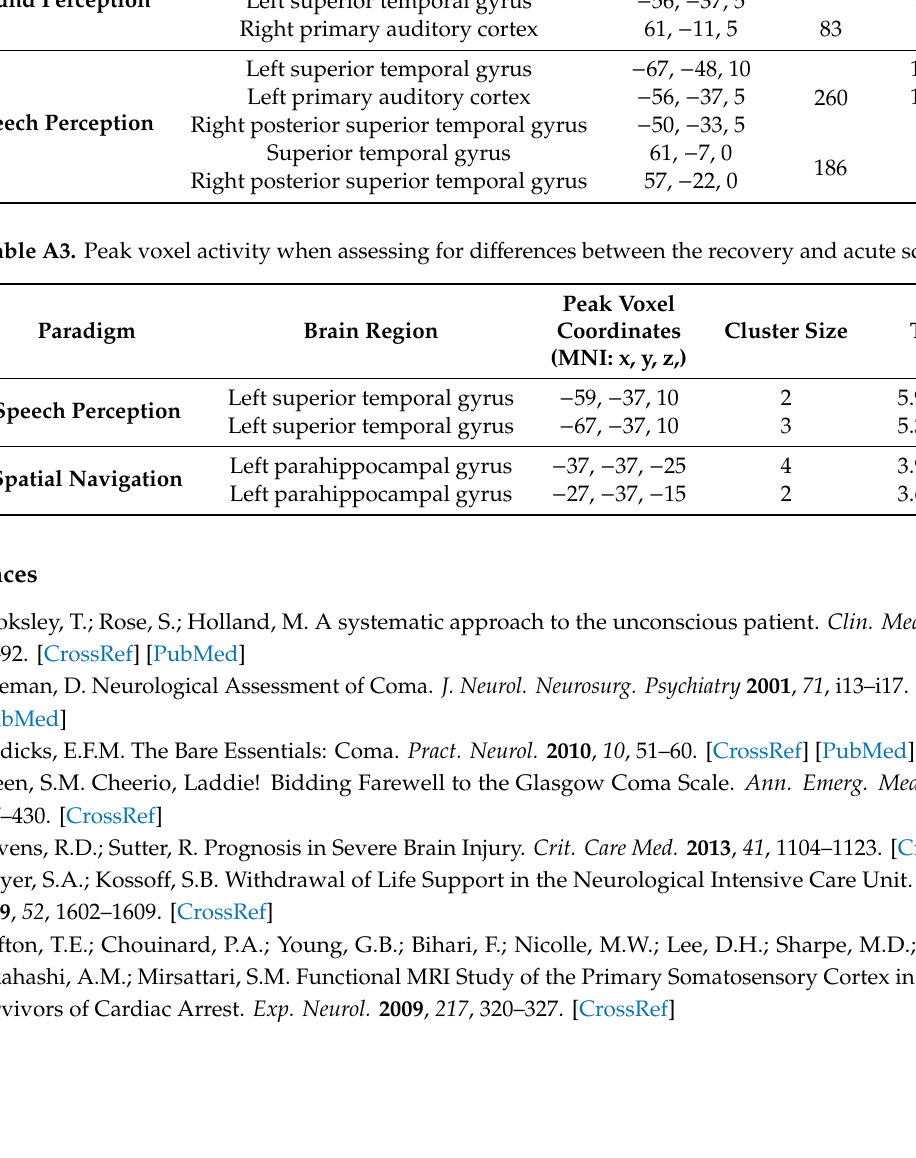
Sound Perception